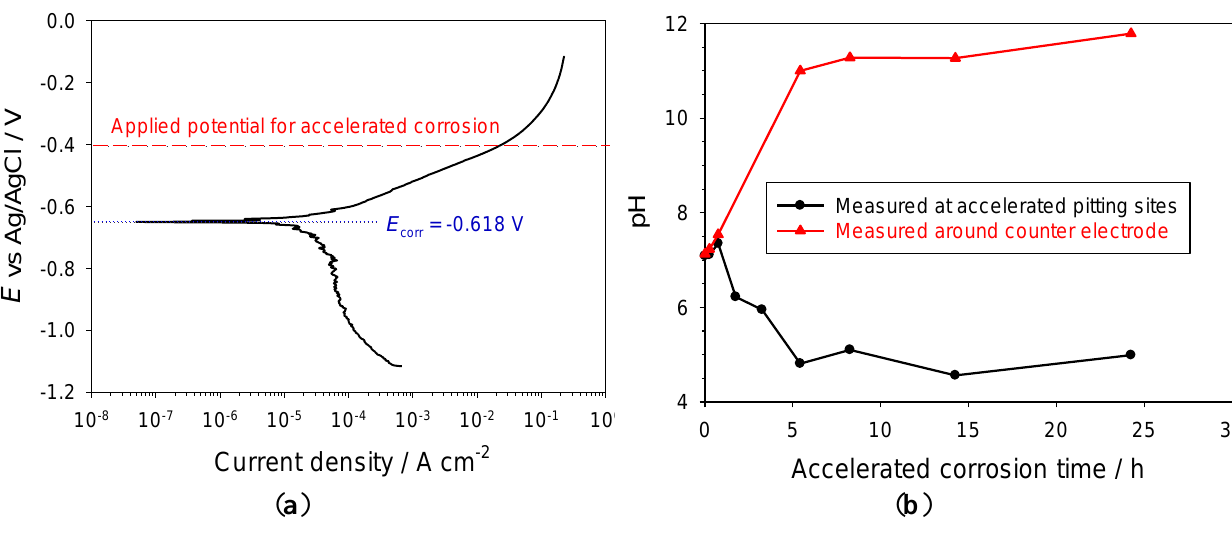
Figure 5. ( a ) Polarisation behaviour at scan rate of 0.150 mV·s −1 ; and ( b ) pH changes at accelerated corrosion sites as well as around counter electrode with accelerated corrosion time at applied potential of −0.400 V for the EN3A carbon steel pencil electrode in 3.5% NaCl